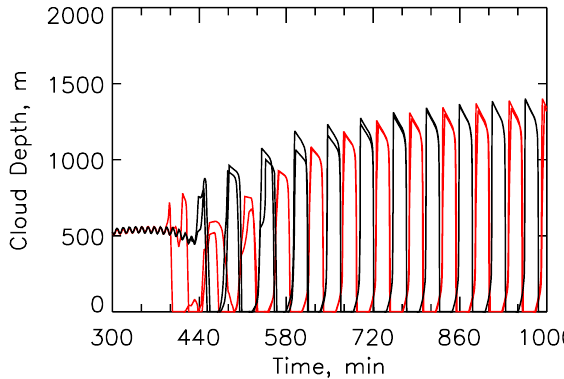
Fig. 2. One-dimensional solution to the equations for I = 21, τ c = 5min ( ∼ 0 . 25 × the microphysical delay T ), and η = − 0 . 51. Red lines: i = 5 and i = 7; black lines: i = 10 and i = 12. Initially all clouds are synchronized with H ’ 500m. At about 380min red lines and black lines diverge. Soon after, odd oscillators (red) are in phase, but out of phase with even oscillators (black). According to Fig. 1, this represents a cloud growing at the expense of its neigh- bours.